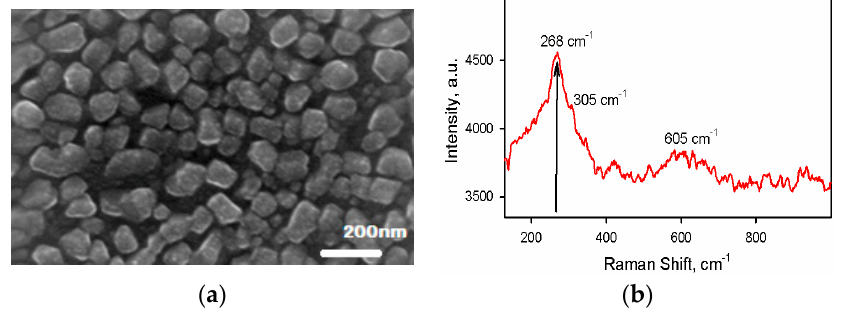
Figure 2. ( a ) SEM image of a device showing CuO nanoparticles uniformly distributed. ( b ) Raman spectra of deposited CuO nanoparticles showing peaks at 268 cm − 1 , 305 cm − 1 , and 605 cm − 1 .